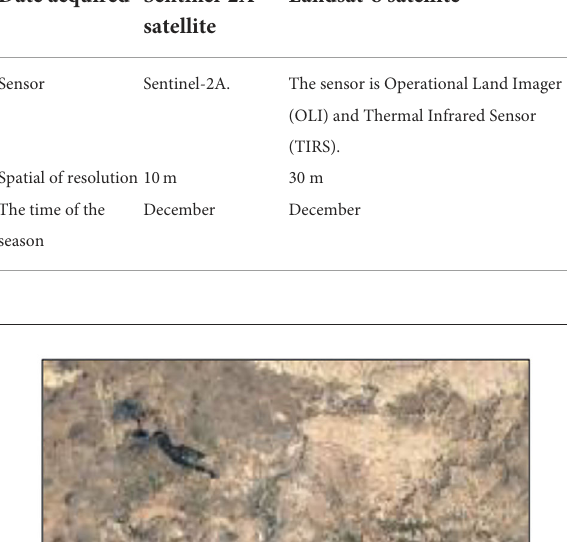
TABLE 1 Data collection from multispectral satellites.